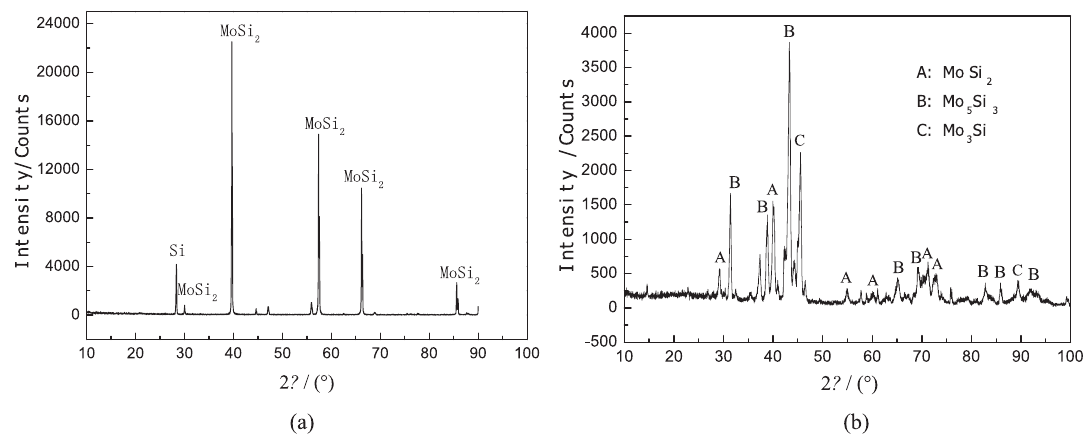
Fig. 5: XRD spectrum of the outer layer (a) and the transitional layer (b)